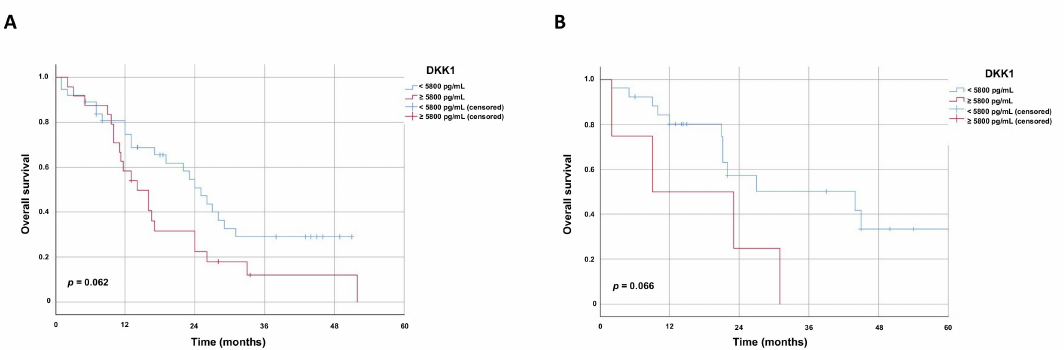
Figure 5. Kaplan–Meier survival curves displaying overall survival of esophageal squamous cell and esophageal adeno- carcinoma patients. Kaplan–Meier survival curves displaying the overall survival in months within the ( A ) esophageal adenocarcinoma and ( B ) esophageal squamous cell cancer patients. Univariate analysis was carried out by the logrank test (Mantel–Cox). A p value < 0.05 was considered as statistically significant. Patients who were lost during follow up were censored at their last documented visit. Time to recurrence of esophageal cancer patients with respect to S-DKK1 levels is displayed. Subgroups were built based on the mean values of all S-DKK1 levels in the 91 esophageal cancer patients (ESCC and